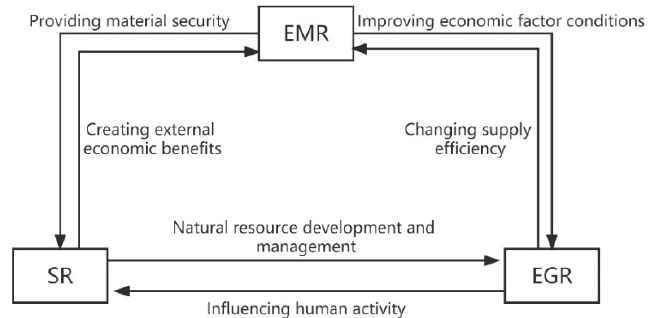
Figure 1. The relationship of economic, social, and ecological